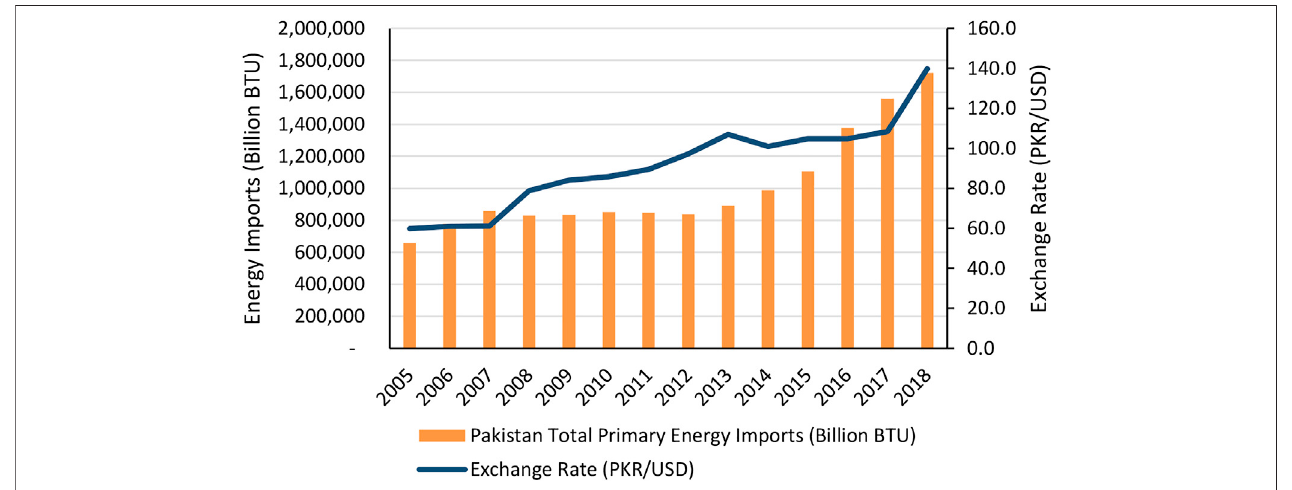
FIGURE 4 | Co-movements of exchange rate and energy imports (2005 – 2018) 4